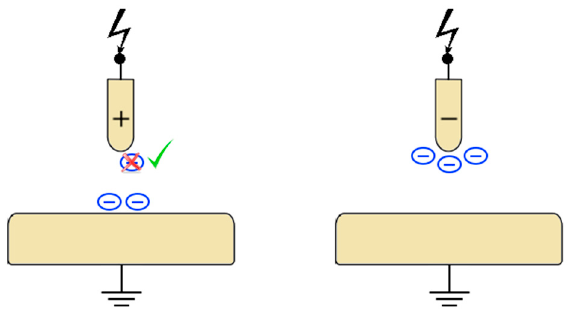
Figure 21. The positions of the initial electrons that triggered the breakdown mechanism between the electrodes before superposing LI voltage stress.